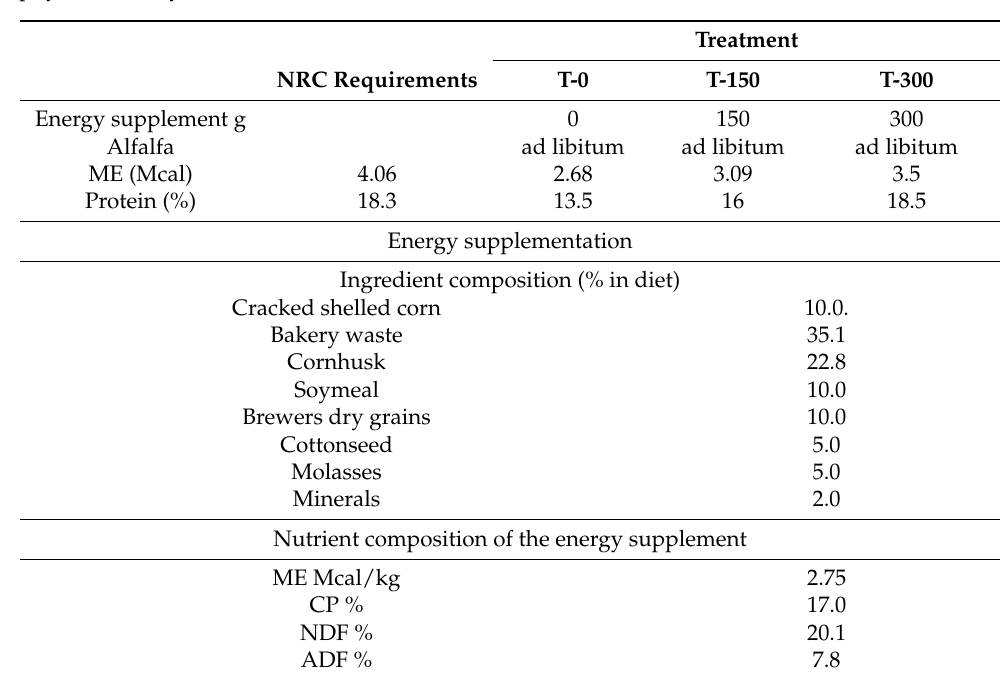
Table 1. Nutrient composition (Dry Matter basis) of the diets offered to pregnant goats during the last third of gestation, compared with the nutrient requirements for a 50 kg pregnant goat with low physical activity